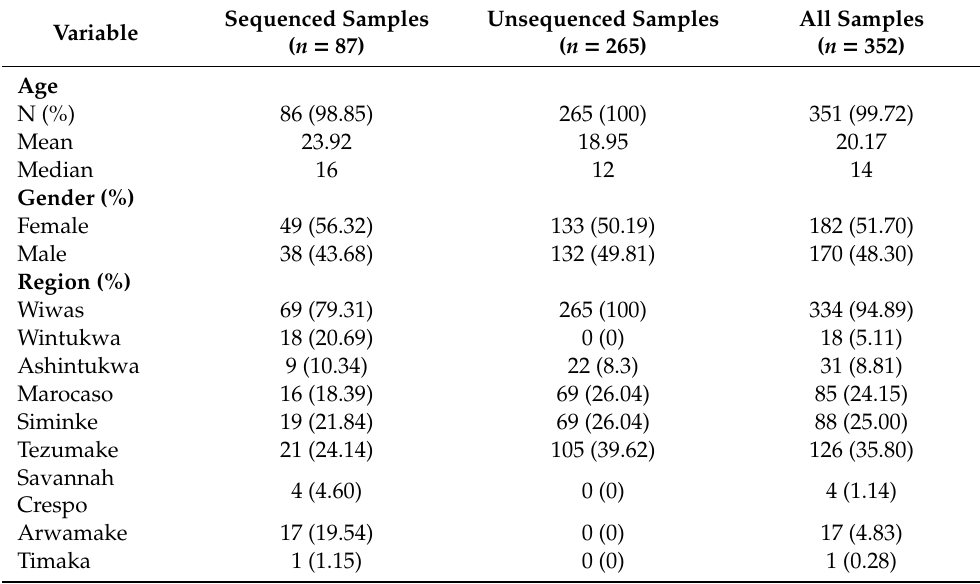
Table 1. Demographic overview of the 352 samples. N =